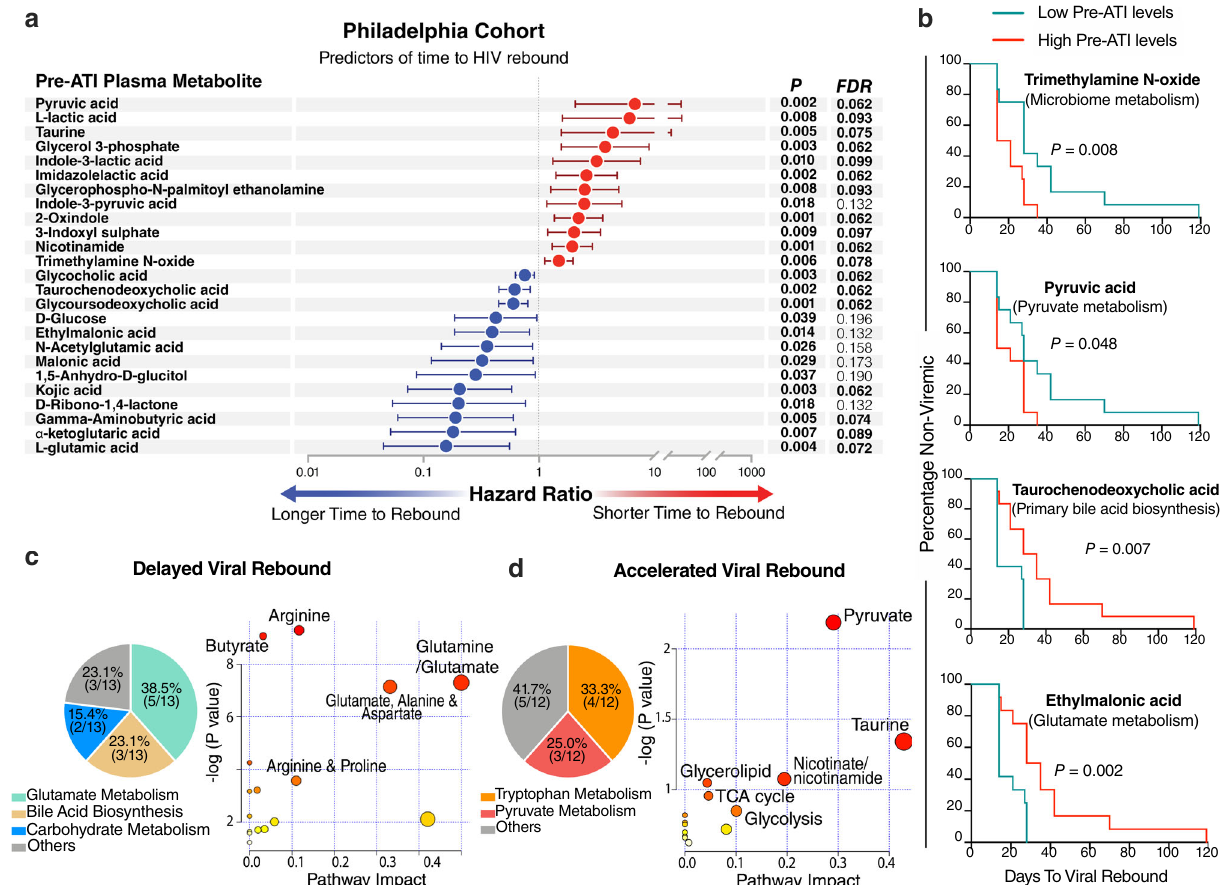
Fig. 1 Plasma metabolites associate with time-to-viral-rebound in the Philadelphia Cohort. a Cox proportional-hazards model of metabolites associated with a longer (blue) or a shorter (red) time-to-viral rebound during Analytic Treatment Interruption (ATI). n = 24 biologically independent samples. Data are presented as hazard ratios with 95% con fi dence intervals. Two-sided P value of each independent variable in the model was used. False Discovery Rate (FDR) was calculated using Benjamini – Hochberg method to correct for multiple comparisons. b Two-sided Mantel – Cox test analysis of four selected metabolites from a . Low pre-ATI levels = lower than group median; High pre-ATI levels = higher than group median. n = 24 biologically independent samples. c Pathway analysis of the 13 metabolites (blue circles in a ) whose pre-ATI levels are associated with a delayed viral rebound. Left image: a multi- analysis approach combining KEGG and STRING Interaction Network. Right image: unbiased analysis using MetaboAnalyst 3.0 (http://www. metaboanalyst.ca/) where the node color is based on P value, and the node radius is based on the pathway impact value. The pathway impact is determined by normalizing the sum of matched metabolites to the sum of all metabolites in each pathway. d Pathway analysis of the 12 metabolites (red circles in a ) whose pre-ATI levels are associated with an accelerated viral rebound. Analysis was performed as in panel ( c ). Source data are provided as a Source Data fi